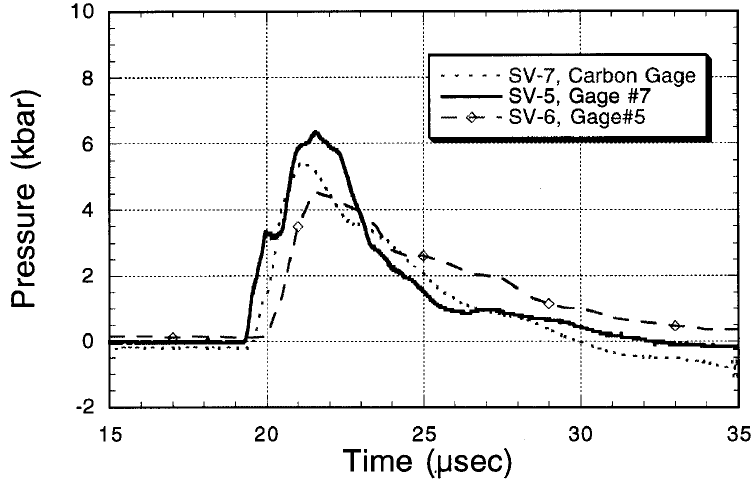
Fig. 4. Comparison of midplane from tourmaline (Shot SV-5), carbon resistor (Shot SV-6) and carbon film (Shot SV-7) gauges.